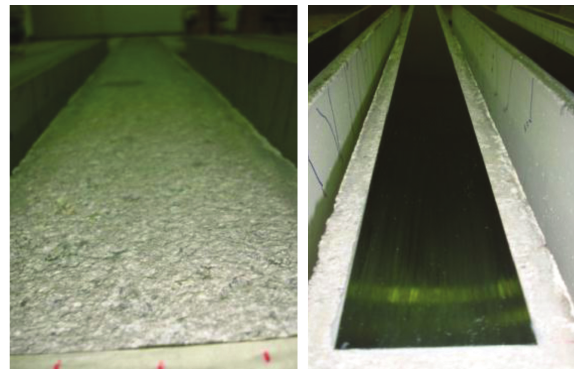
Fig. 3. Surface preparation and CFRP fi xing